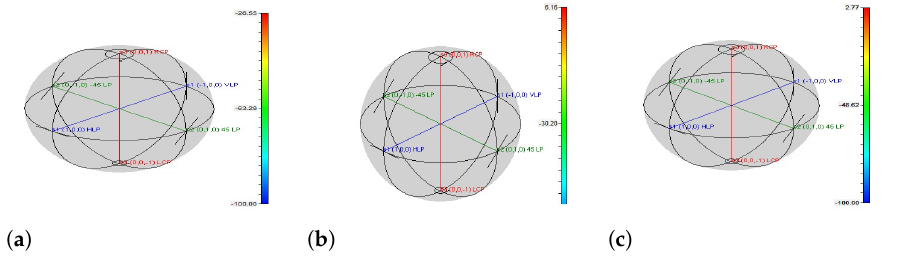
Figure 7. Polarization analyzer; ( a ) conventional laser based OWN outcomes, ( b ) polarization analyzer performance using ML-based VCSEL for OWN, and ( c ) VCSEL-based OWN results with using ML technique.